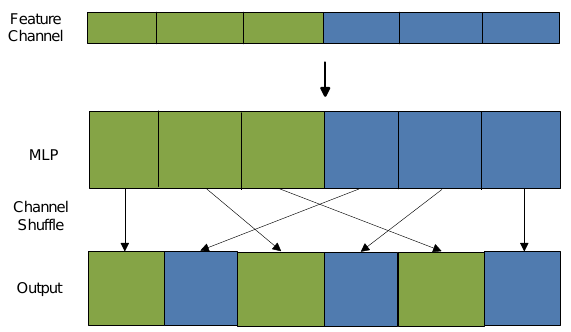
Figure 3. Ordered channel shuffle with MLP operation.